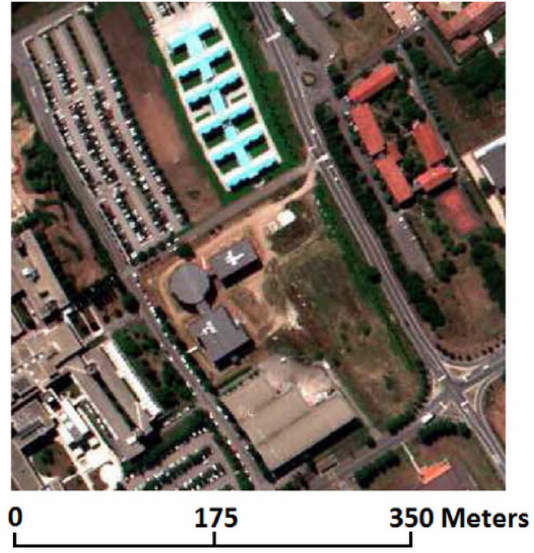
Figure 2. The image of Pavia